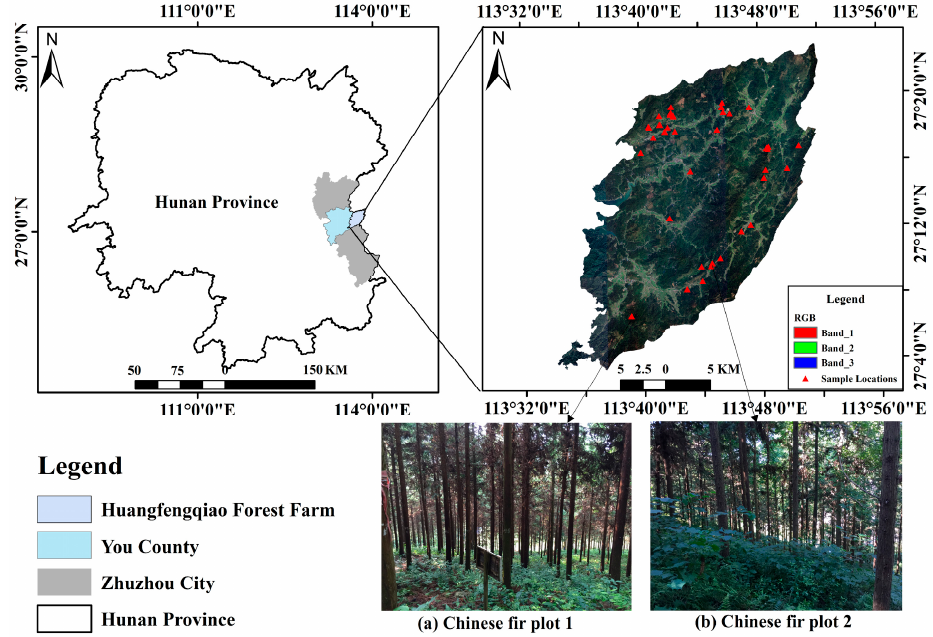
Figure 1. The position of study area and the distribution map of ground samples in planted Chinese fir forest, RGB image is the optical image of Huangfengqiao Forest Farm during the corresponding period.